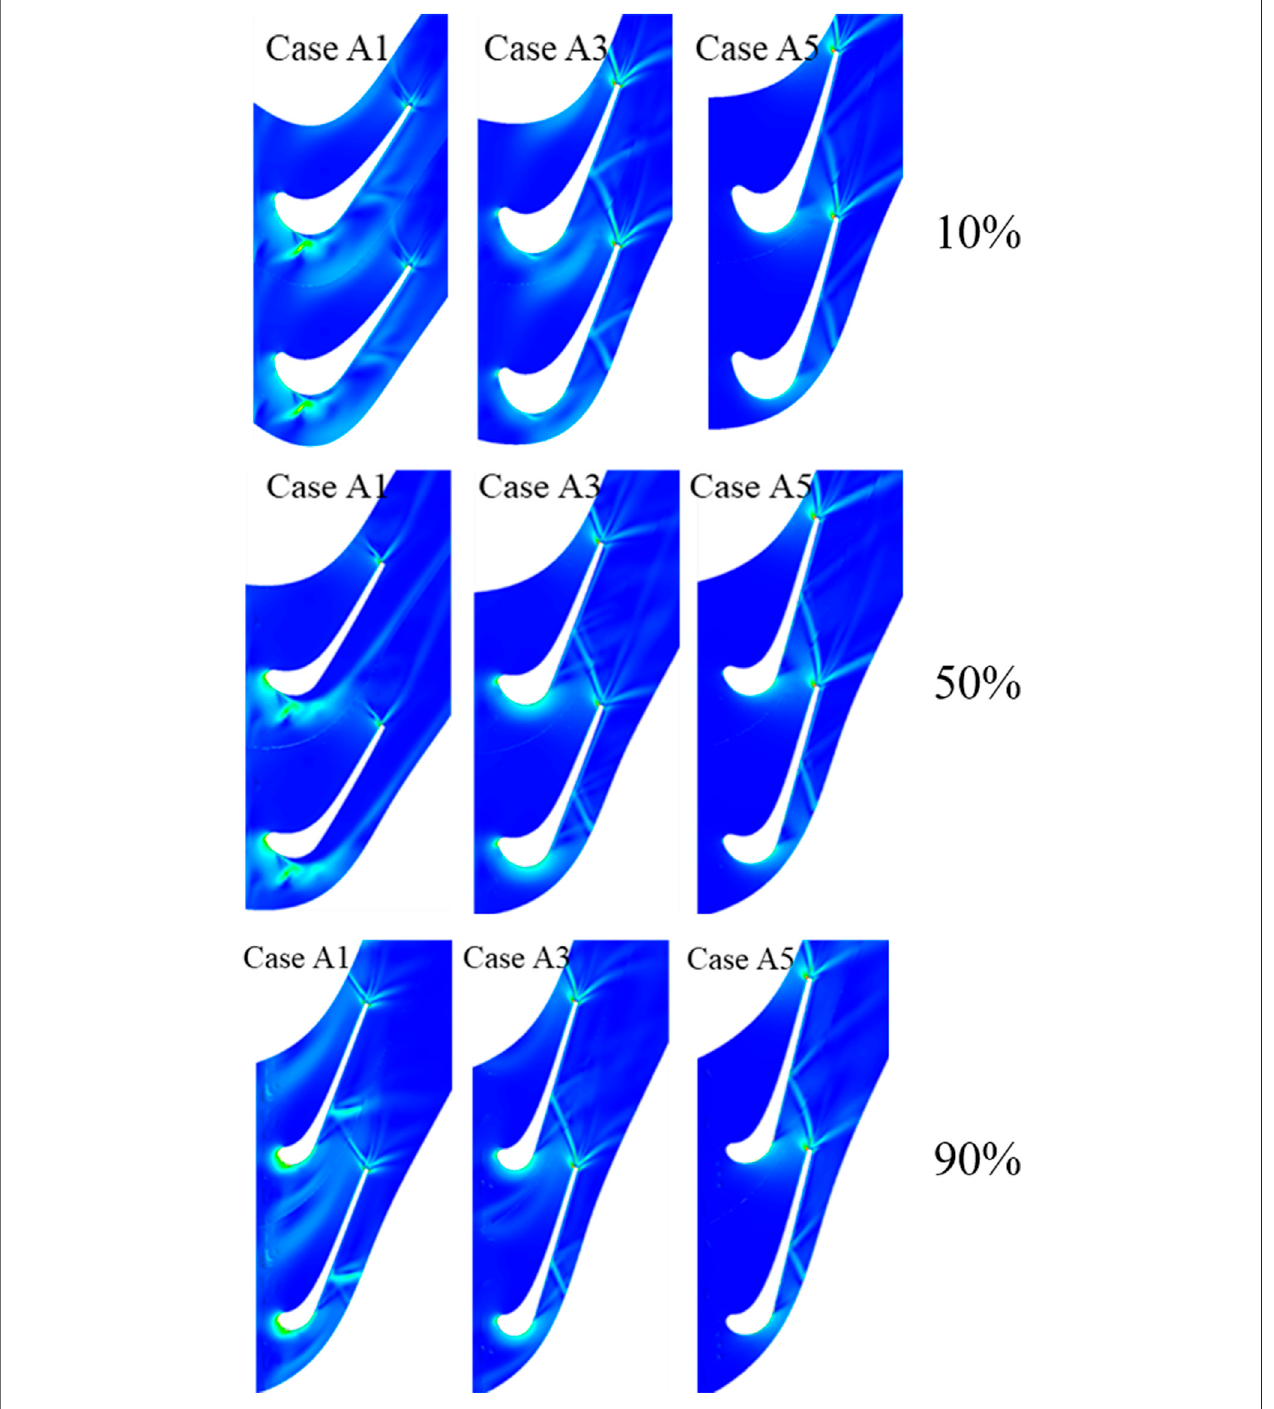
FIGURE 11 | Density gradient distribution of rotors for different